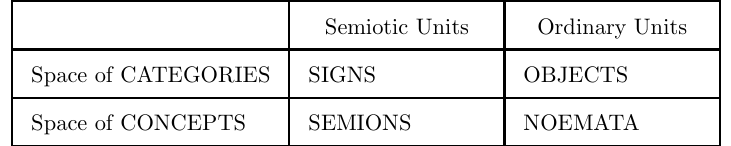
Table 1 Elementary and Integrative Units of Language and Mental